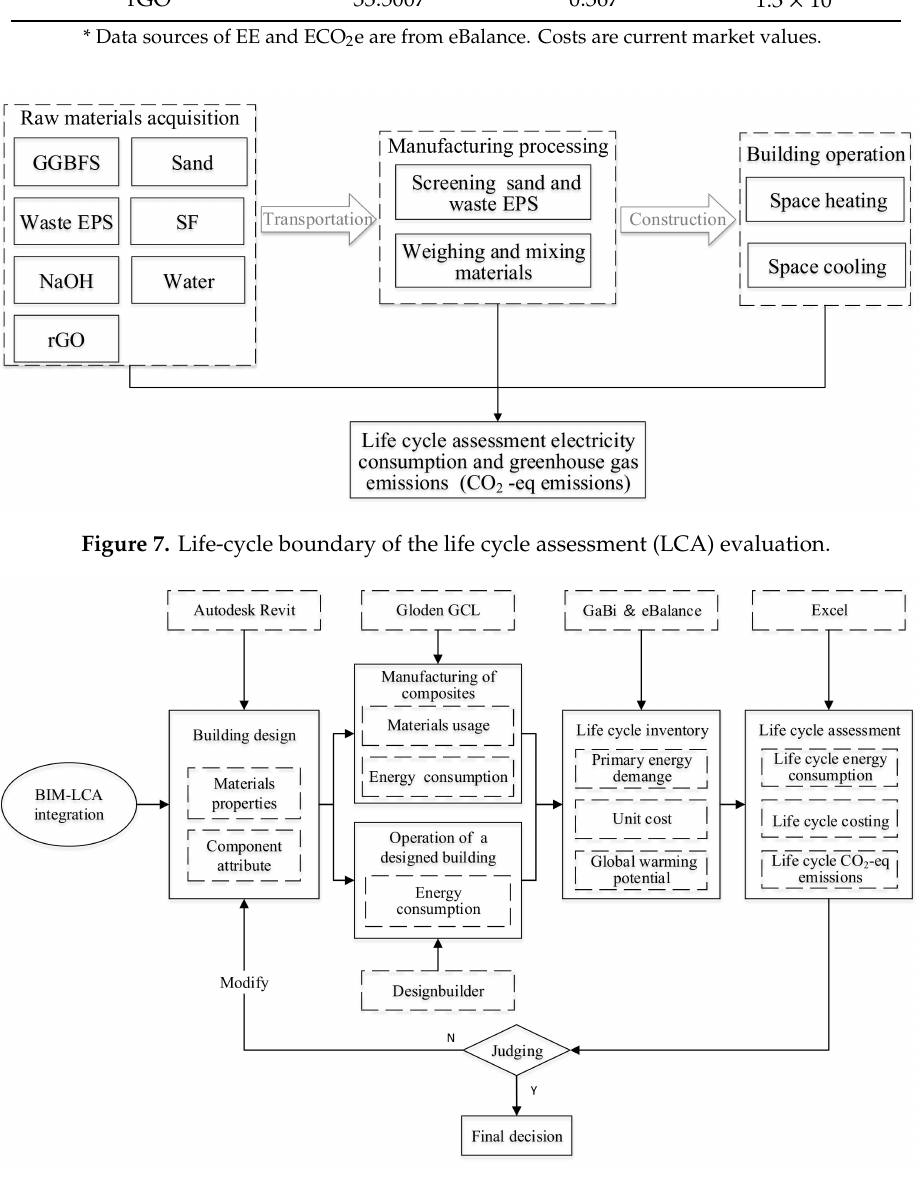
Figure 8. Flow chart of building information modeling (BIM) for energy conservation